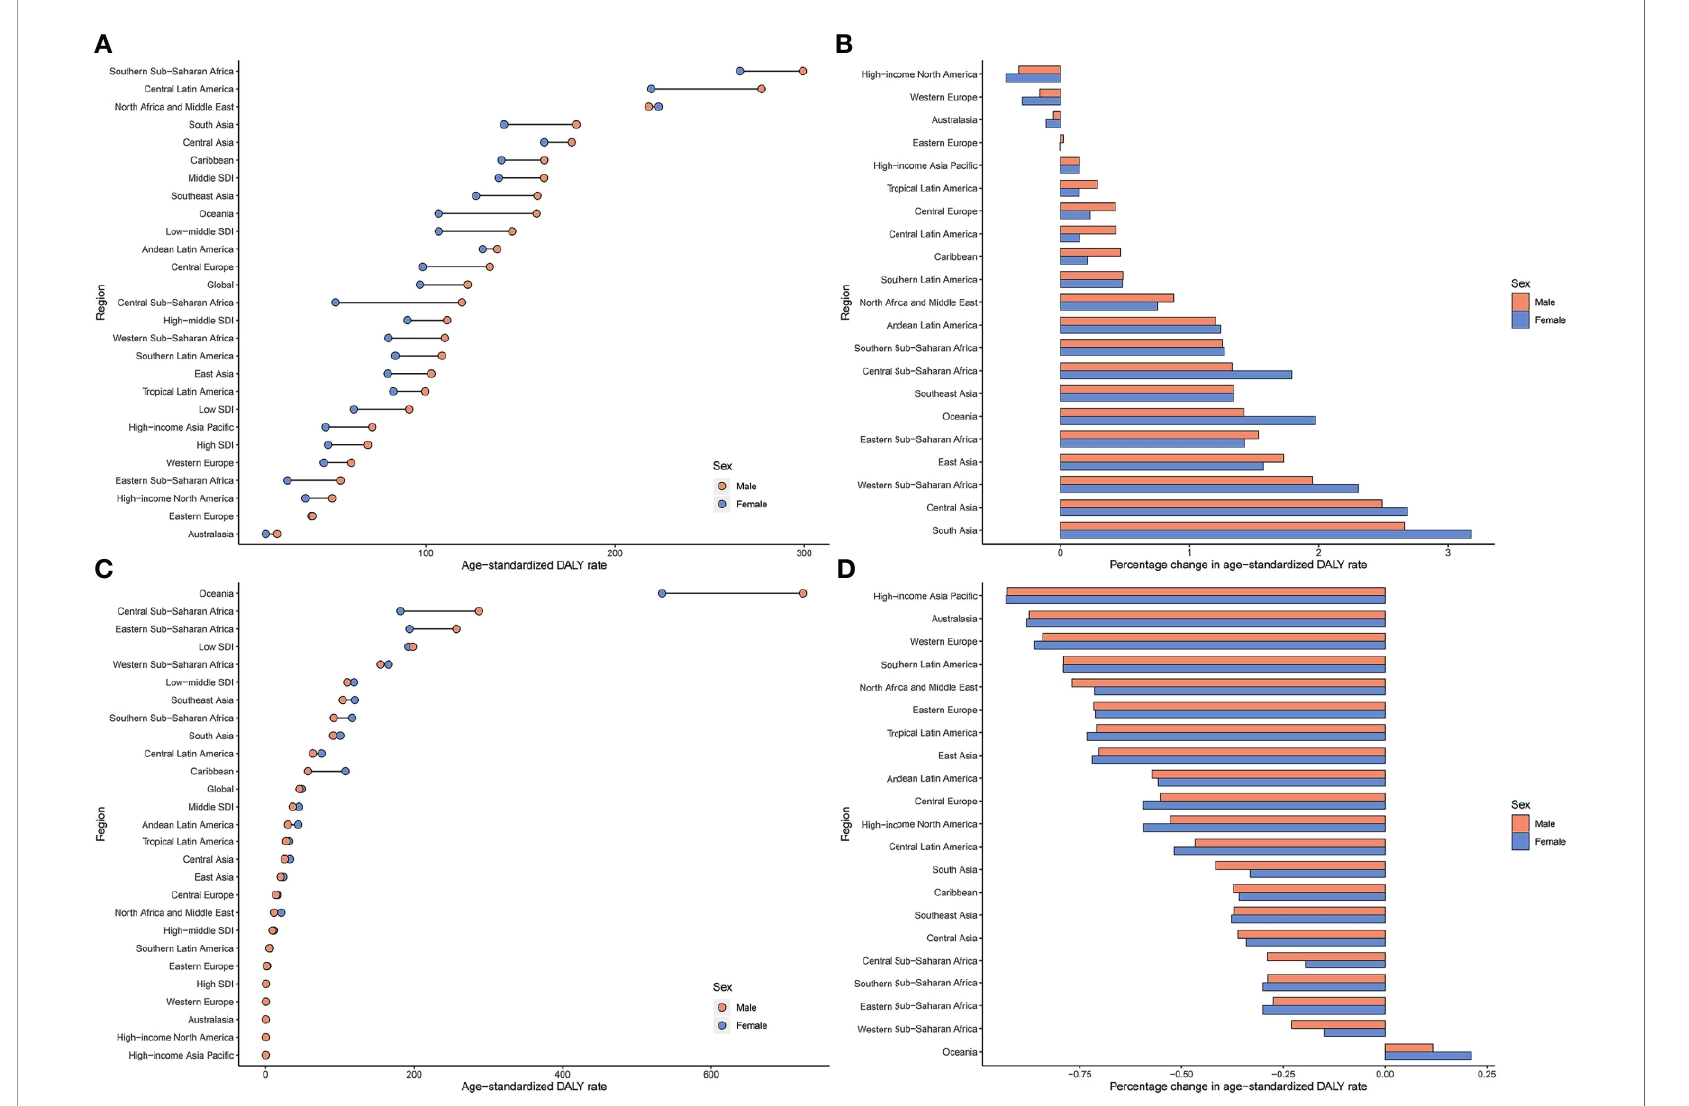
FIGURE 3 | Age-standardized DALY rates of type 2 diabetes mellitus attributable to particulate matter pollution in 2019 and their percentage changes in rates from 1990 to 2019 across 21 GBD regions among different genders. (A) Age-standardized DALY rates of type 2 diabetes mellitus attributable to APMP; (B) Percentage changes in age-standardized DALY rates attributable to APMP from 1990 to 2019; (C) Age- standardized DALY rates of type 2 diabetes mellitus attributable to HAP; (D) Percentage changes in age-standardized DALY rates attributable to HAP from 1990 to 2019. APMP, ambient particulate matter pollution; DALY, disability-adjusted life-year; HAP, household air